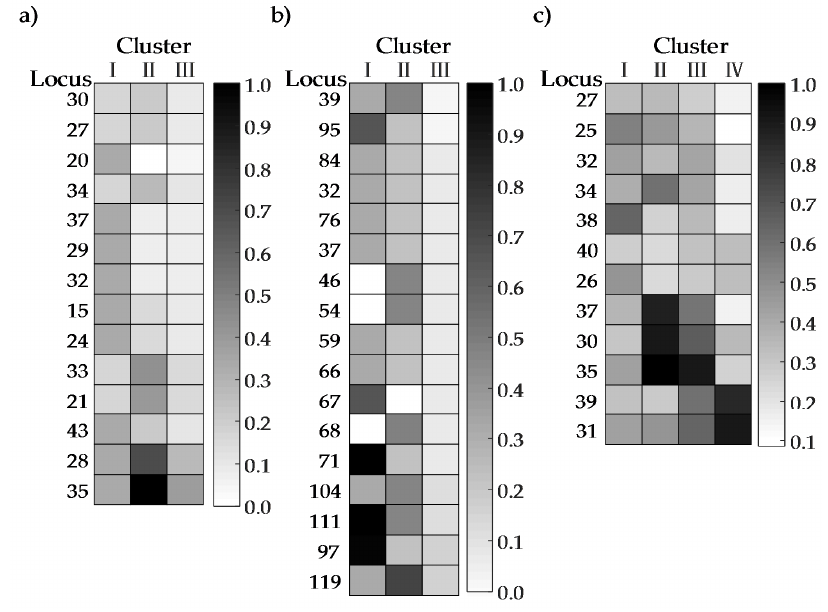
Figure 8. Cluster differences after recognition of altered data in Hydropsyche albicephala ( a ); Stenopsyche marmorata ( b ); and Hydropsyche orientals ( c ). The gray levels in the cells and the vertical bar indicate the degree of cluster difference ( F value normalized to 0–1 according to the maximum in each species). The order of outlier loci was according to the D value from top down.